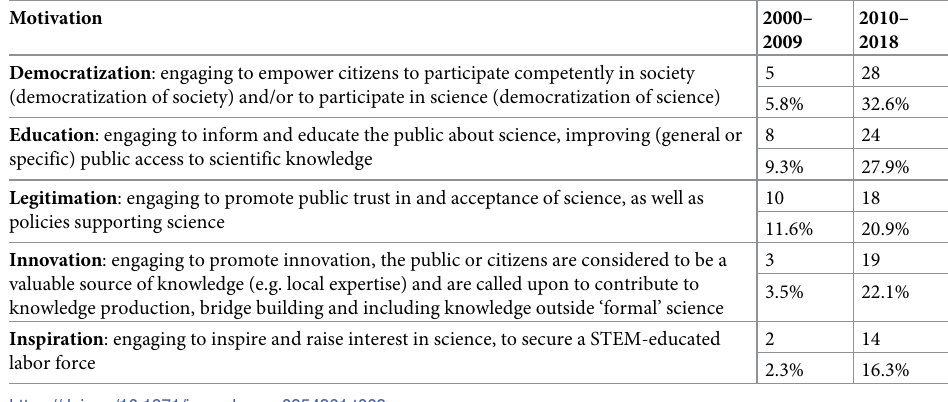
Table 2. Primary motivations for engagement in academic literature.